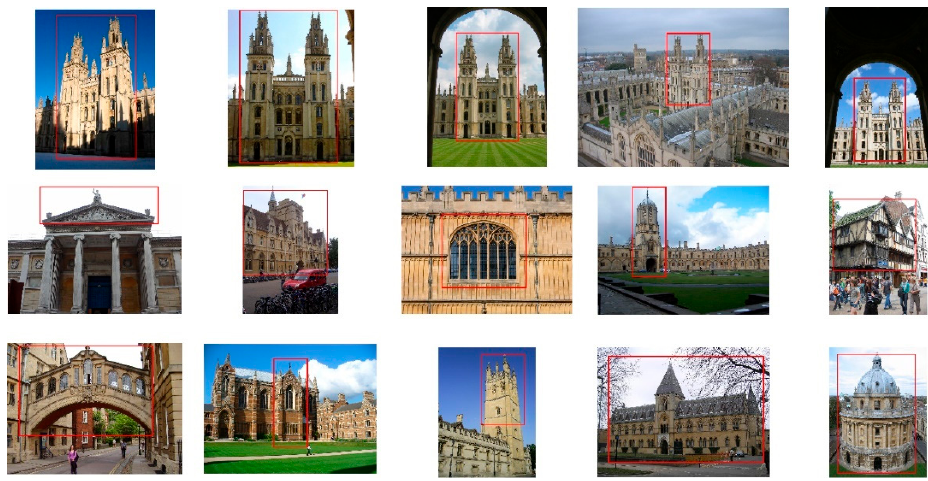
Figure 15. Typical images of the Oxford buildings dataset (the first row is five different queries of the first category, and the last two rows of images are specific queries of the other ten